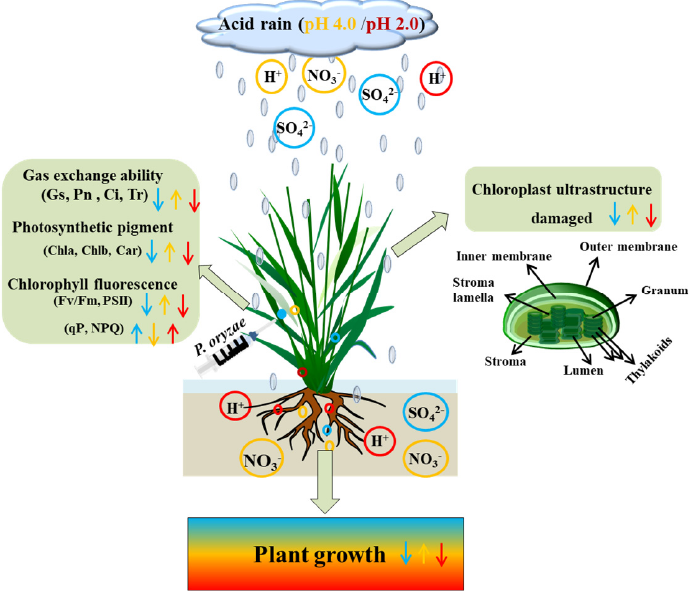
Figure 7. The mechanisms of SAR (pH) and inoculation of P. oryzae effects on plant growth. The blue, yellow, and red arrows indicate the changes induced by inoculation with P. oryzae , medium ‐ acidity acid rain (pH 4.0) and high ‐ acidity acid rain (pH 2.0), respectively; up and down arrows indicate up ‐ and down ‐ regulation of traits, respectively. Gs, stomatal conductance; Pn, net photo ‐ synthetic rate; Ci, intercellular CO 2 concentration; Tr, transpiration rate; Chla, Chlorophyll a; Chlb, Chlorophyll b; Car, Cartenoid; Fv/Fm, maximum quantum yield; PSII, potential activity of PSII; qP, photochemical quenching; and NPQ, non ‐ photochemical quenching of fluorescence. As the figure shows, medium ‐ acidity acid rain can help the plant to cope with the detrimental effect of P. oryzae on plant photosynthetic characteristics and chloroplast structure, while the scenario is just reversed in case of high ‐ acidity acid rain and P. oryzae.